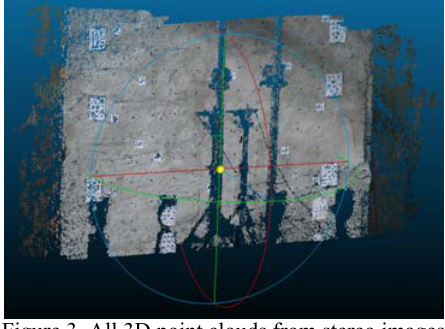
Figure 3. All 3D point clouds from stereo images